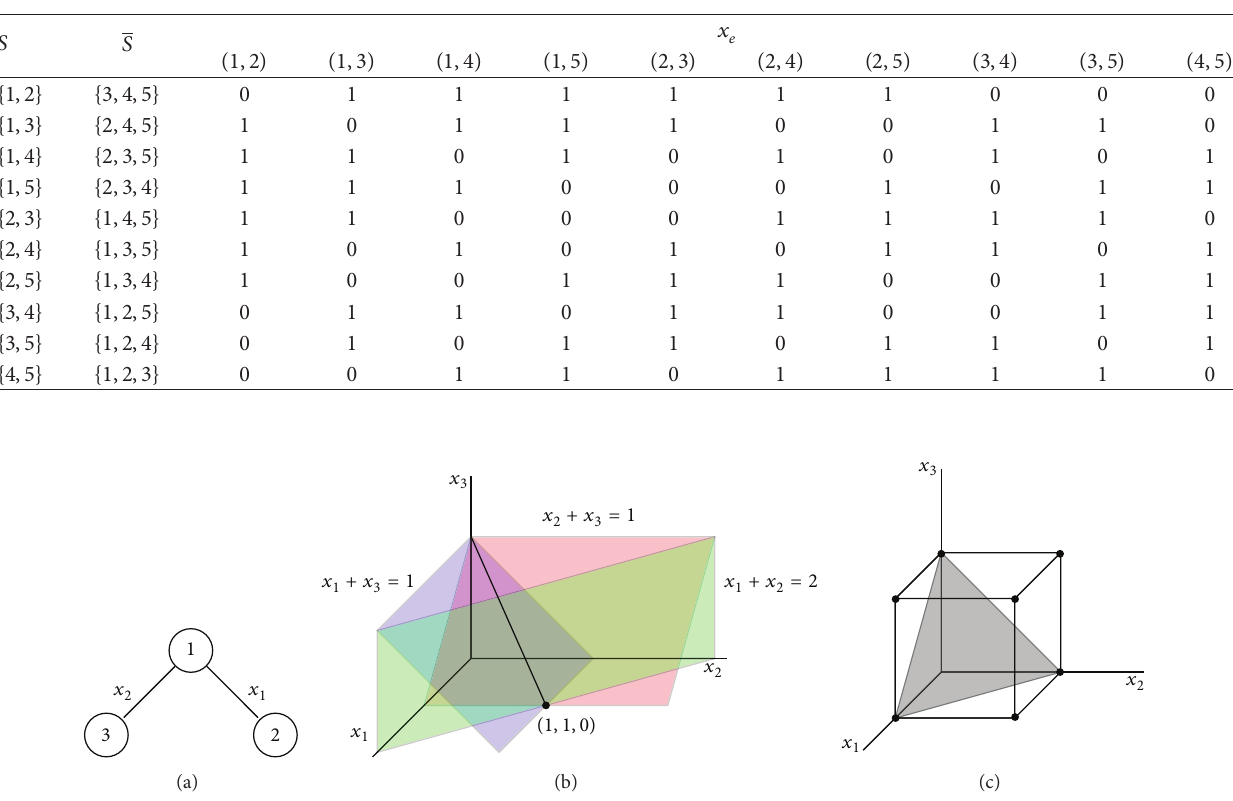
Table 1: The incidence vectors 𝑥 for different cutsets 𝛿(𝑆) showing edges between 𝑆 and its complement 𝑆 .